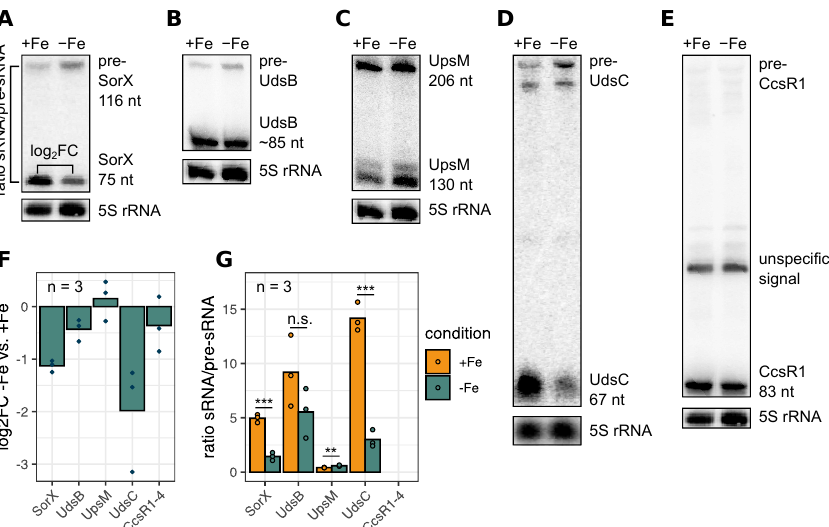
Figure 8. Iron availability influences the RNase E dependent processing of UTR-derived sRNAs. Total RNA from R. sphaeroides wild type cultures grown in media supplemented with iron (+Fe) or after iron depletion ( − Fe) was isolated and analyzed via northern blot. Membranes were hybridized with probes directed against sRNAs which are processed by RNase E: SorX ( A ), UdsB ( B ), UpsM ( C ), UdsC ( D ) and CcsR1 ( E ). The experiment was performed in biological triplicates. 5S rRNA served as loading control. Full blots with samples from biological triplicates are shown in Figure S10. ( F ) log 2 fold changes of the mature sRNA species were calculated comparing the − Fe and +Fe conditions. Grey bars indicate the mean value, every dot represents one biological replicate, n = 3. ( G ) Signals of the sRNAs and pre-sRNAs were quantified and the ratio was calculated (y-axis). Bars indicate the mean value (+Fe: yellow, − Fe: green), every dot represents one biological replicate, n = 3. Groups were compared with the two-sided Student’s t -test: *** p -value < 0.001; ** p -value < 0.01; n.s. not significant. Signal of the CcsR1 precursor was too low for